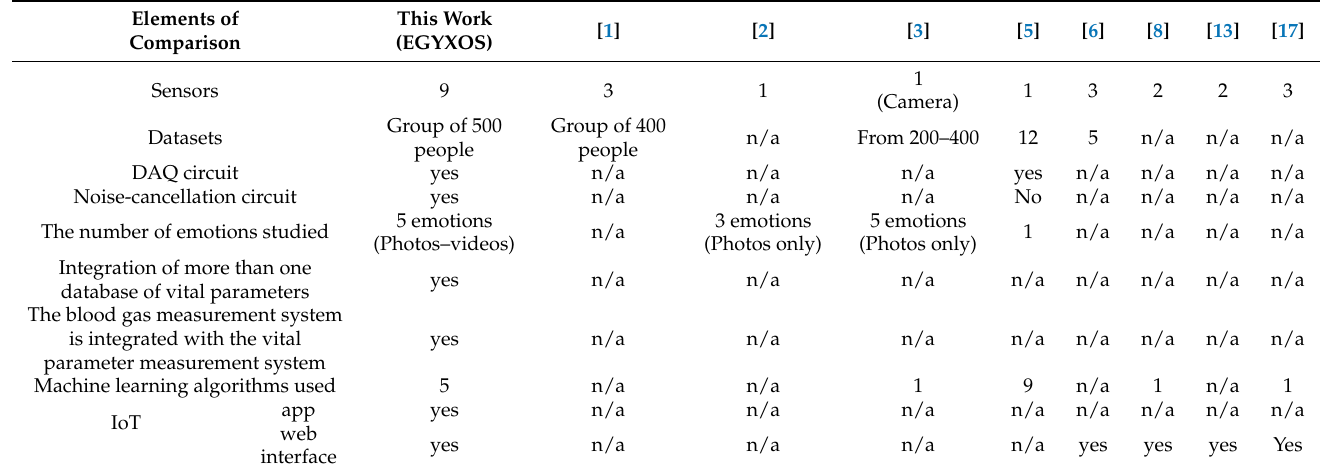
Table 13. The differences between the EGYXOS system and the previous systems.